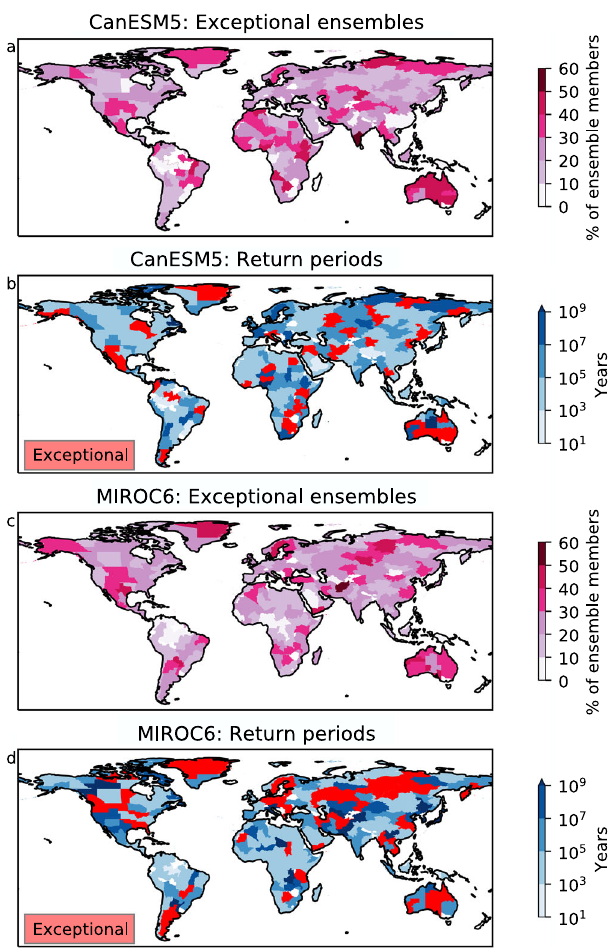
Fig.4|GlobalmapofrecordsoutsideofGeneralisedExtremeValue(GEV) fi tin climate model data. a For a 50-member ensemble of CanESM5, 1959 – 2015, cal- culatedusing eachensemblememberseparatelyhow manymembersshow record events outside the GEV fi t. b Taking all ensemble members to fi t a single GEV distribution, the returnperiod of the current record. Red regions indicate where it is not possible to calculate a return period because the event falls outside of the GEV fi t. c As in ( a ), for a 50-member ensemble of MIROC6. d As in ( b ) for MIROC6. Regions from Stone (2019) 31 . Source data are provided as a Source Data fi